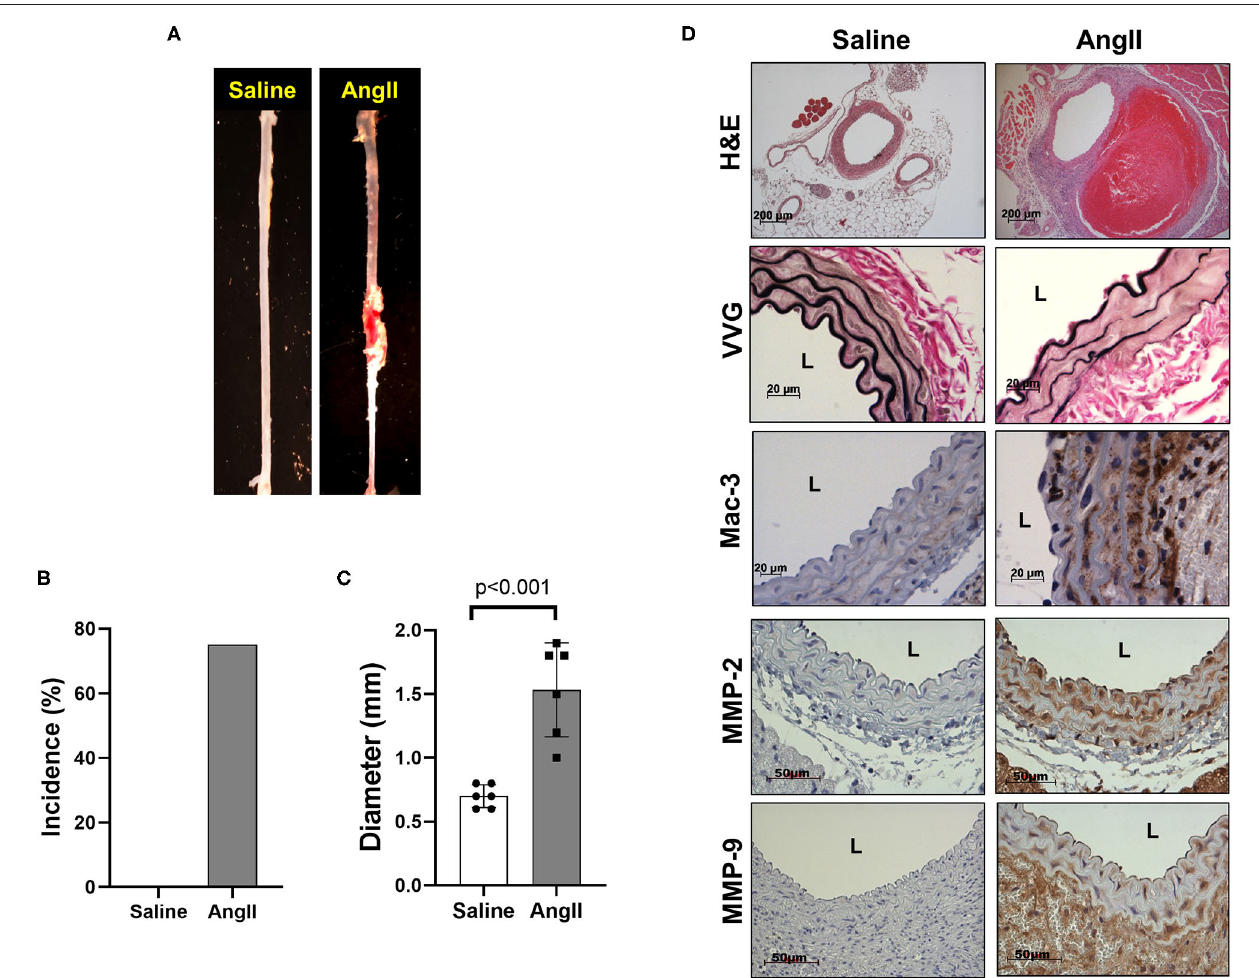
FIGURE 1 | AngII formation by AngII infusion. AngII was infused via osmotic minipump in LDLR KO mice for up to 3 weeks. (A) Representative image of AAA formation by AngII infusion in the suprarenal area of mouse aorta. (B) AAA incidence. (C) Aortic diameter. (D) Representative histology; H&E, VVG (elastin fragmentation), Mac-3 (macrophages) and MMP-2/-9, L, lumen.